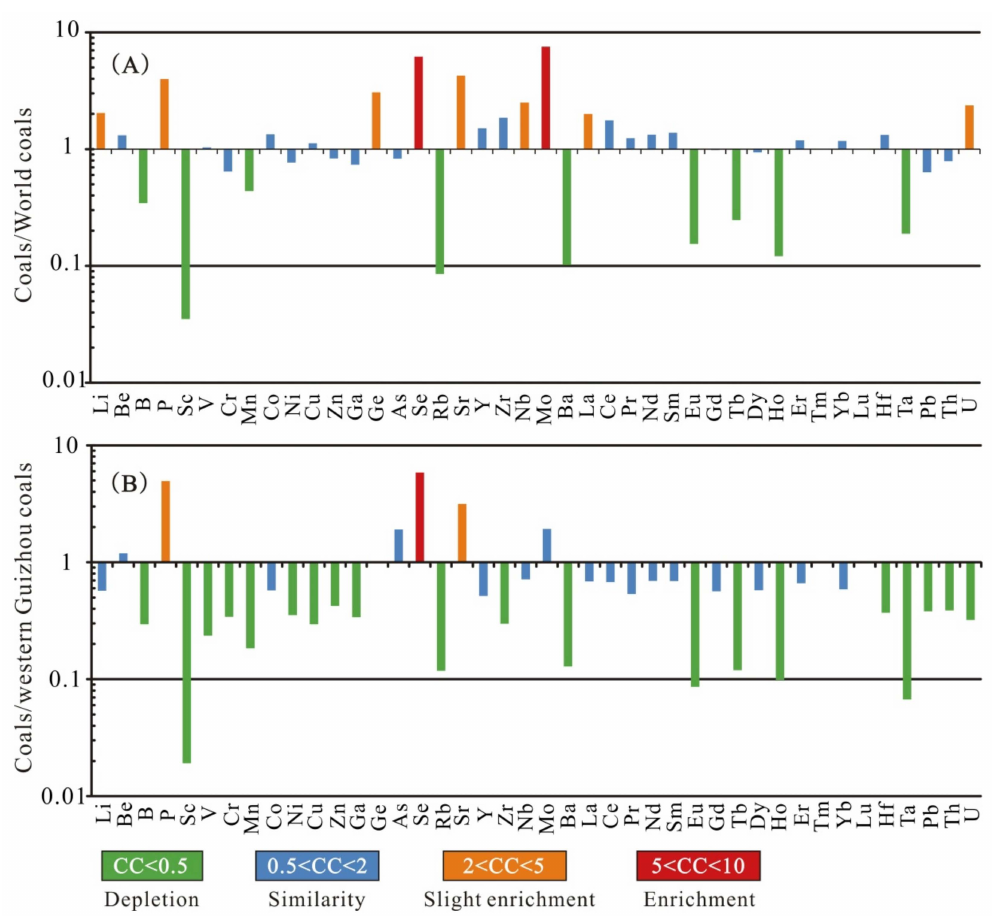
Figure 11. Concentration coe ffi cients (CC) of trace elements in the study coals, normalized to the respective average of world coal ( A ) [52] and western Guizhou coal ( B )